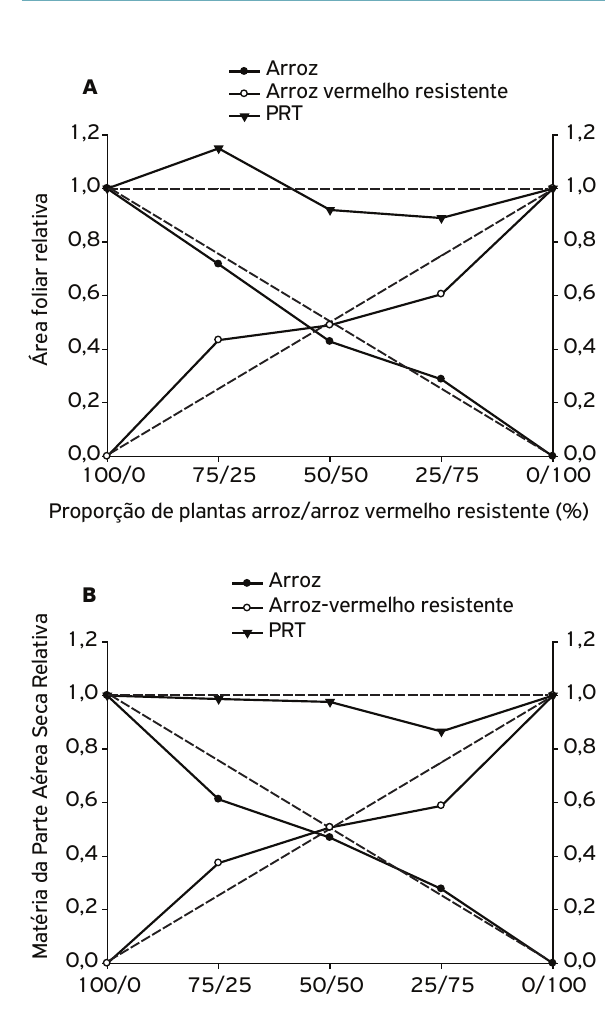
Tabela 2. Resposta de biótipos de arroz-vermelho suscetível e resistente ao herbicida imazapyr + imazapic em competição com arroz cultivar Puitá INTA CL.